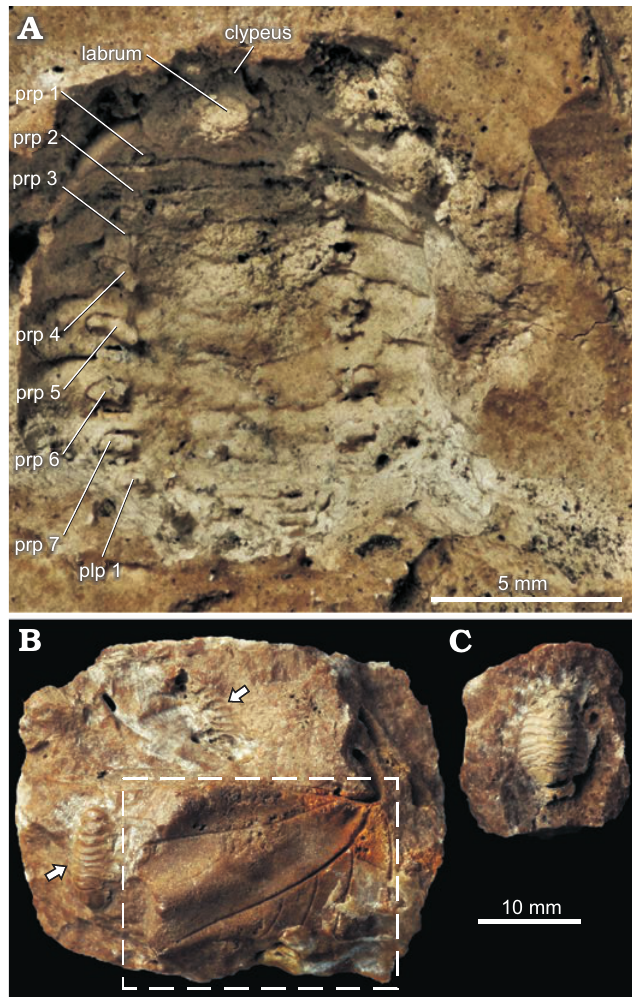
Fig. 4. Detailed anatomy of isopod Heterosphaeroma priscum (Milne- Edwards, 1868), late Thanetian of Sézanne, Marne, France. A . SU.PAL.2017. 0.2.3.1, ventral view. B . SU.PAL.2017.0.2.3.2-1, dorsal view and leaf co-oc- currence (dashed), isopod individuals (arrows). C . SU.PAL.2017.0.2.3.2-2, dorsal view. Abbreviations: pln, pleonite; plp, pleopod; prn, pereonite; prp, pereopod. Photographs RV and Rémi Brageu